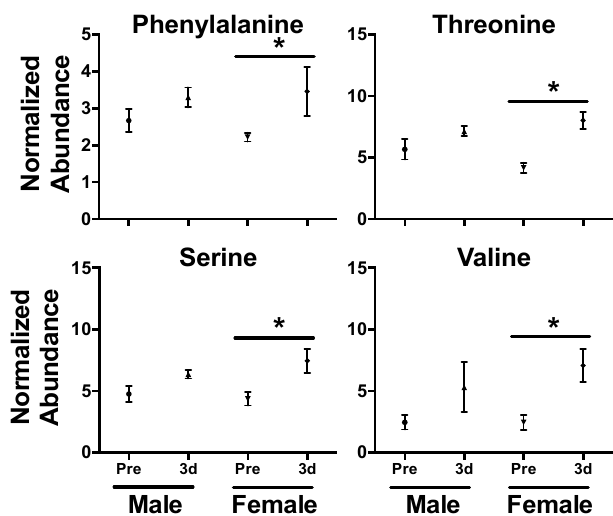
Figure 3. Sex differences in serum amino acid levels 3 d after a 4 Gy γ -ray TBI in NHPs. While levels increased for both males and females after exposure, higher fold changes were observed in phenylalanine, threonine, serine, and valine in females. (* P < 0.05 determined by a t -test, mean ± SEM., pre-exposure samples [-8 and -3 d] were averaged for the control group).